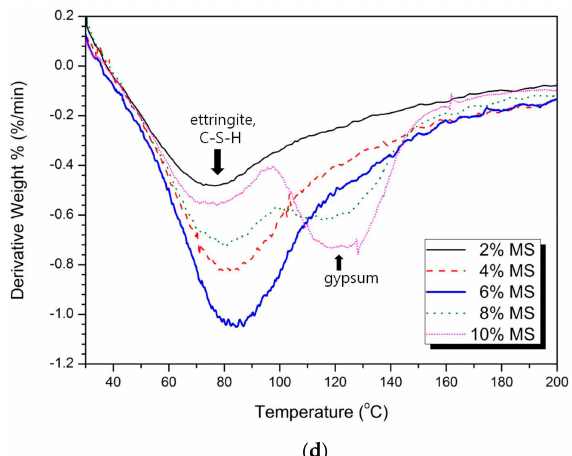
Figure 4. Thermal analysis results: ( a ) 3 days, ( b ) magnification of the red dotted rectangle in ( a ), ( c ) 28 days, ( d ) magnification of the red dotted rectangle in ( c